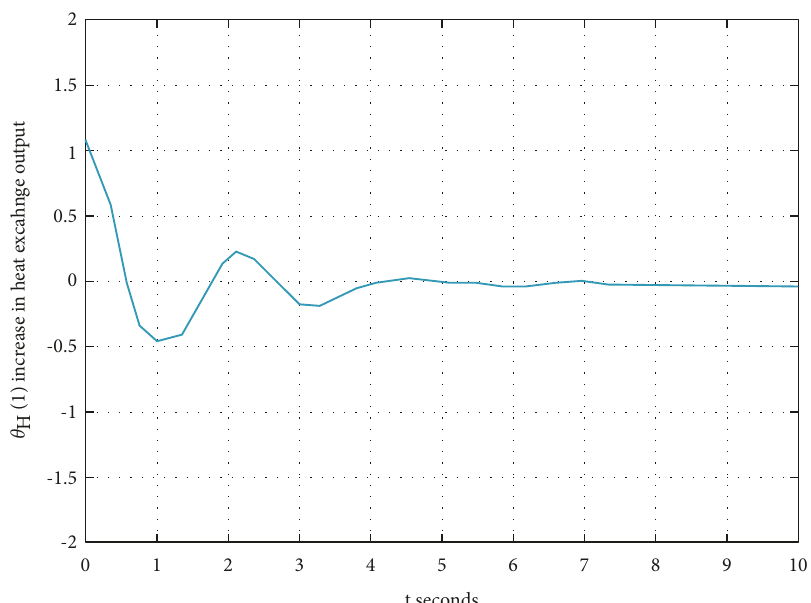
Figure 4: Progression of Δ (t) less than zero delay condition.